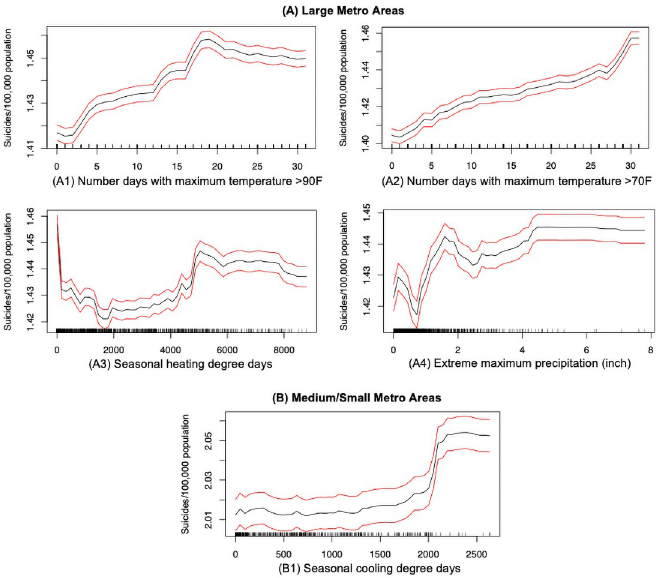
Fig 11. Suicide mortality rate and climate: (A) Large metro areas; (B) Medium/small metro areas. Rug lines on the x axis indicate prevalence of data points; black curve is the average marginal effect of the predictor variable; red lines indicate the 95% confidence intervals.